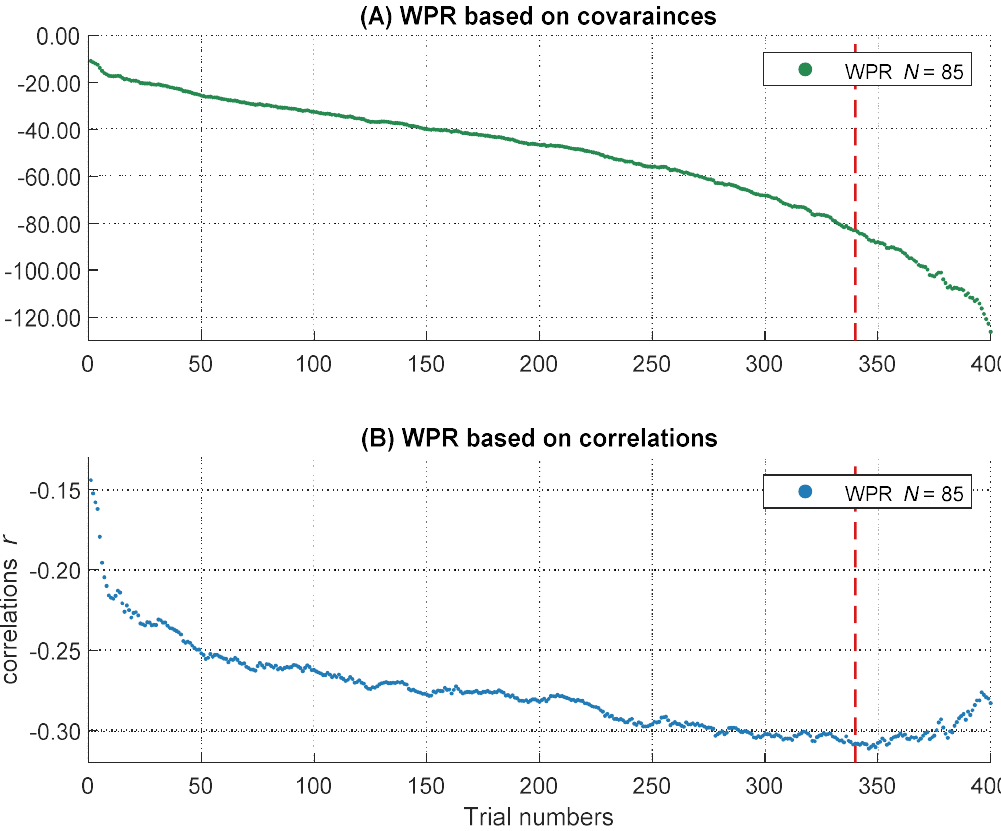
Figure 3. The increasing magnitude of negative correlations and covariances over RT distribution. The course of the covariances over 400 trials is shown above ( A ), the course of correlations over 400 trials is shown below ( B ). The dashed line represents the 85 percent threshold. Only the left part of the red dashed line was analyzed in the following multi-level analyses.